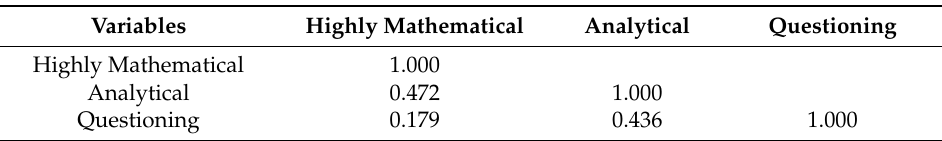
Table A5. Pearson’s Zero-Order Correlation Coefficients from Bivariate Pairs of Skill Scale Traits Describing Self (Simard et al.